Question: How would you classify this visualization?
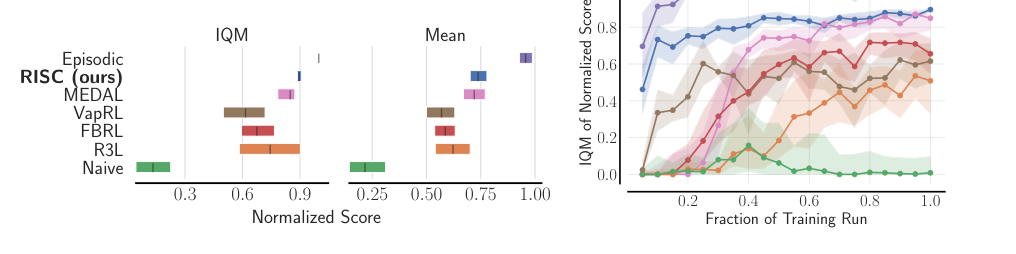
Answer: line